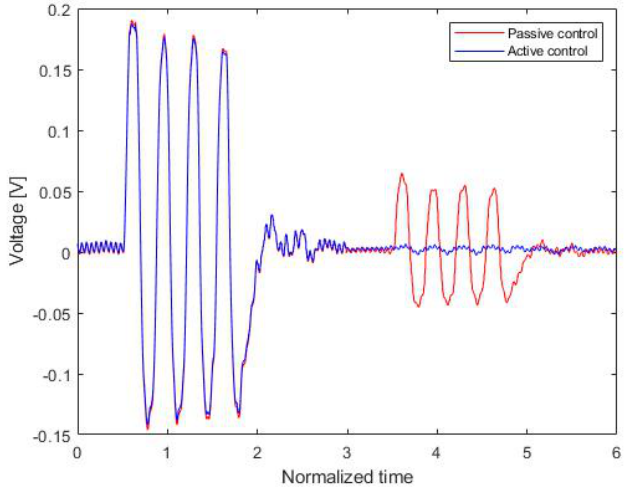
Figure 14. Time variation of the measured signal.